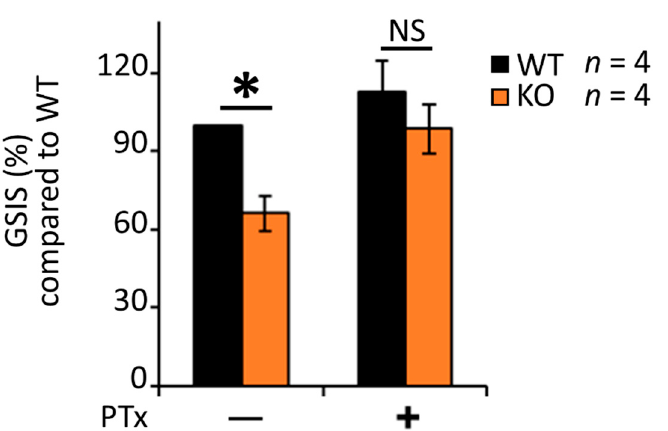
Figure 5. Pertussis toxin (PTx) largely corrects the glucose-stimulated insulin secretion defect in RGS4-deficient islets. Glucose-stimulated insulin secretion (GSIS) was measured in isolated islets from WT and RGS4-KO mice following 30 min glucose challenge (20 mM) with and without the addition of 0.2 µg/mL PTx. Data are expressed as GSIS% relative to that for WT islets. * p < 0.05; NS, not significant [one-way ANOVA and Tukey’s post-hoc test].